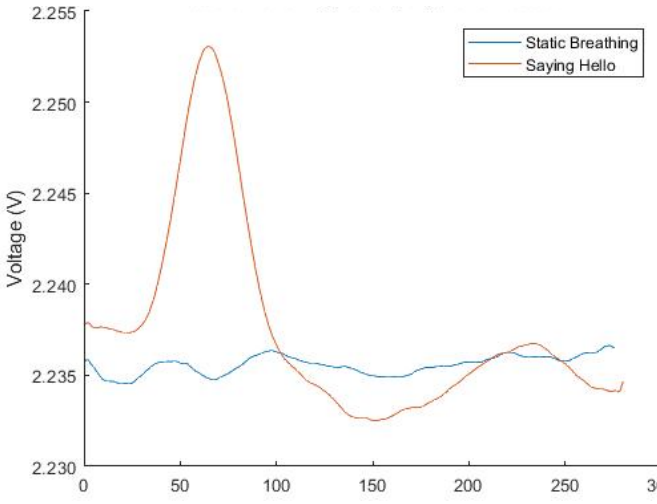
Figure 10. Sensor readings from static breathing and saying